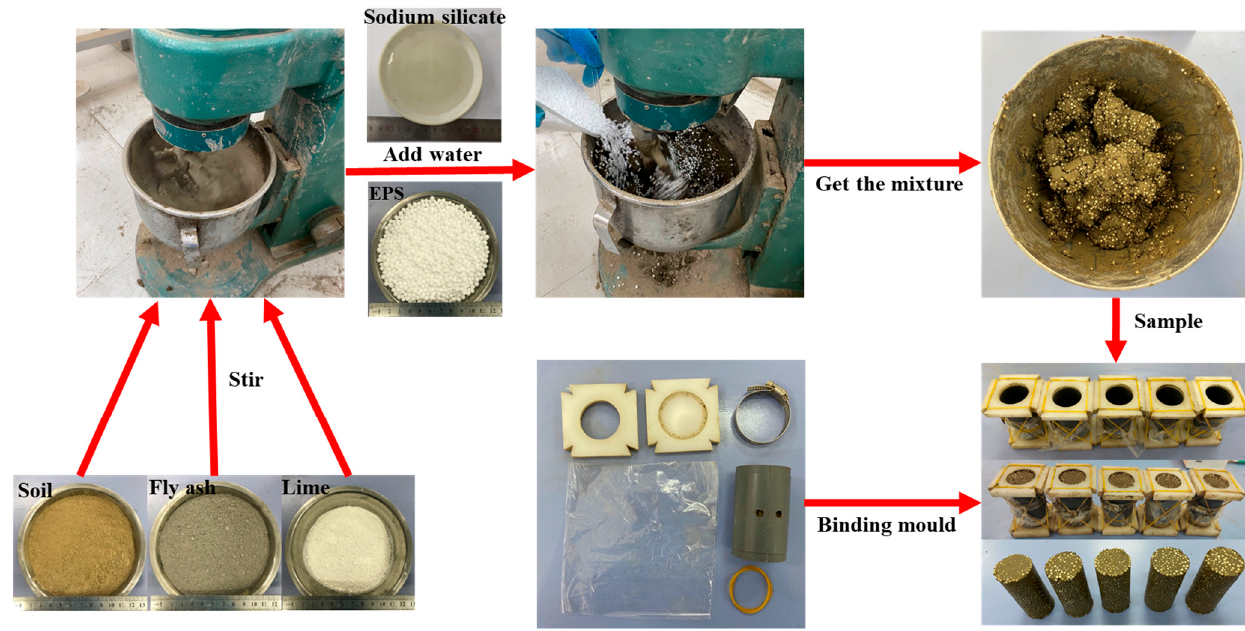
Figure 4. Sample preparation process.